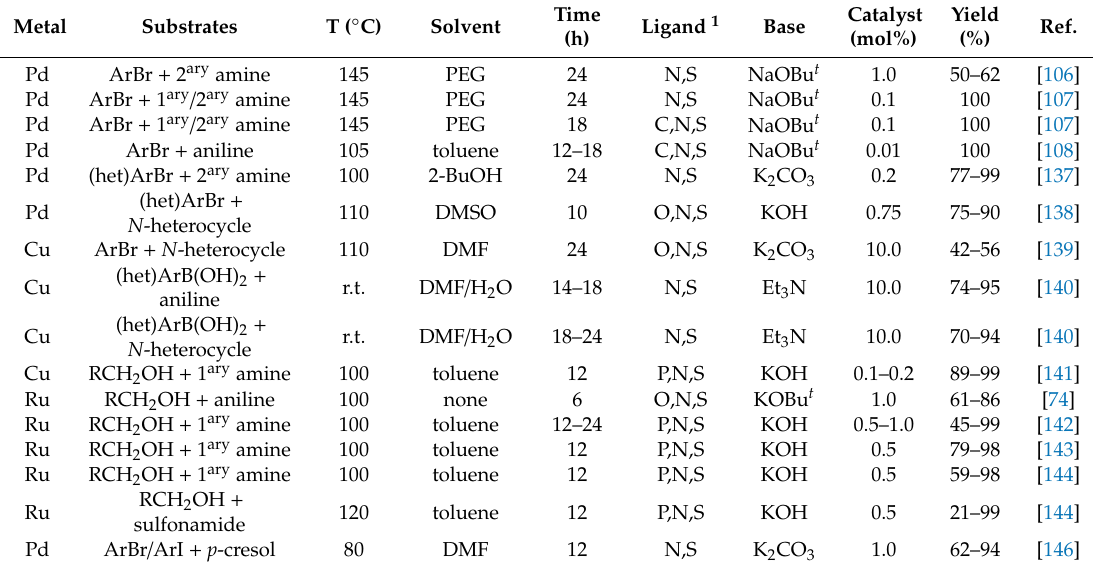
Carbon–heteroatom coupling reactions catalysed by thiosemicarbazone complexes: representative conditions and